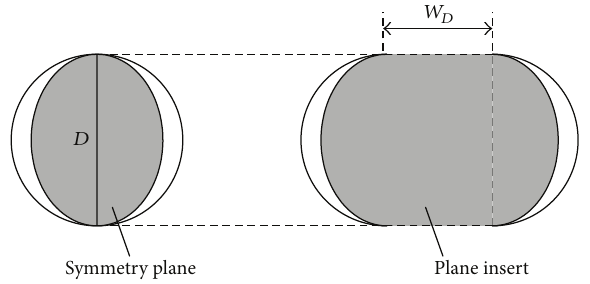
Figure 2: The evolutionary progress of the collapse failure mecha- nism from a single circular tunnel to DOT tunnel.